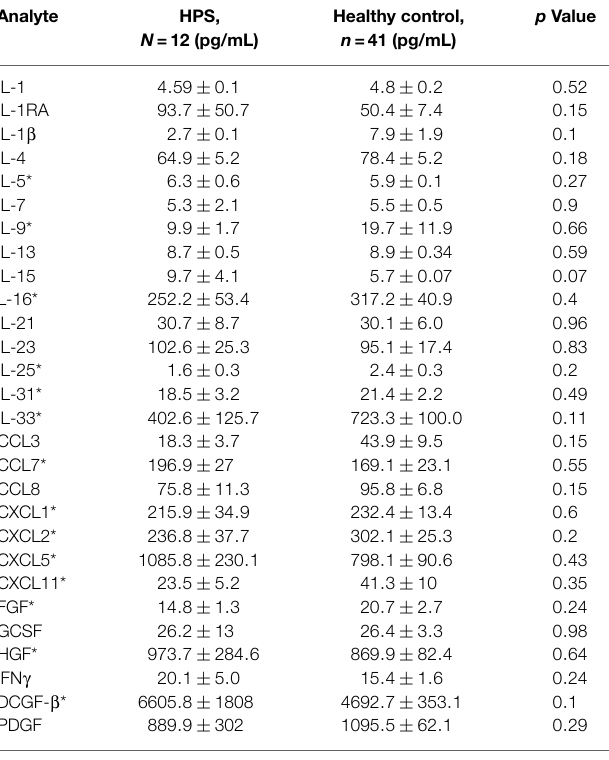
TABLE4 | NosignificantdifferenceincytokineexpressionbetweenHPSand healthy controls . Analyte HPS, Healthy control, p N =12 (pg/mL) n =41 (pg/mL)